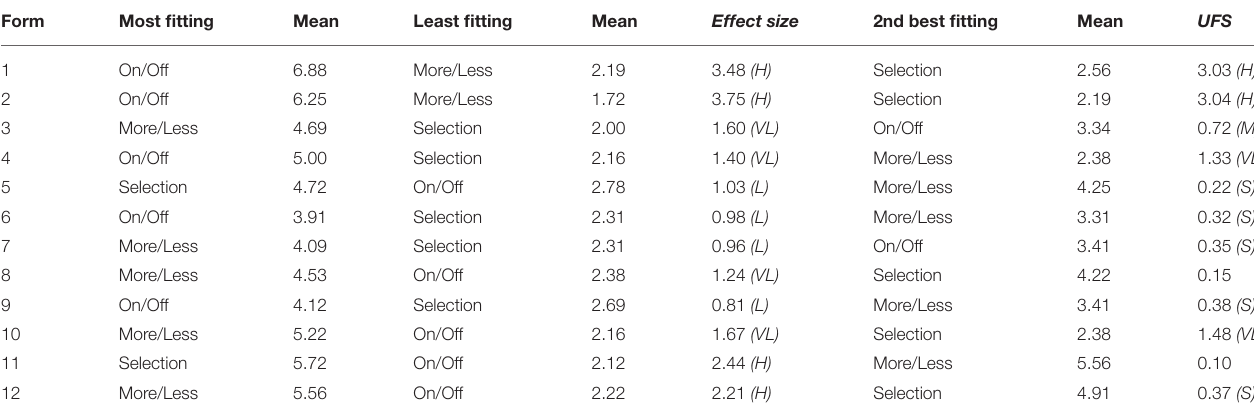
TABLE 4 | Uniqueness fitting score (UFS) and effect sizes for fitting ratings for each of the forms across the functionality categories on/off, more/less, and